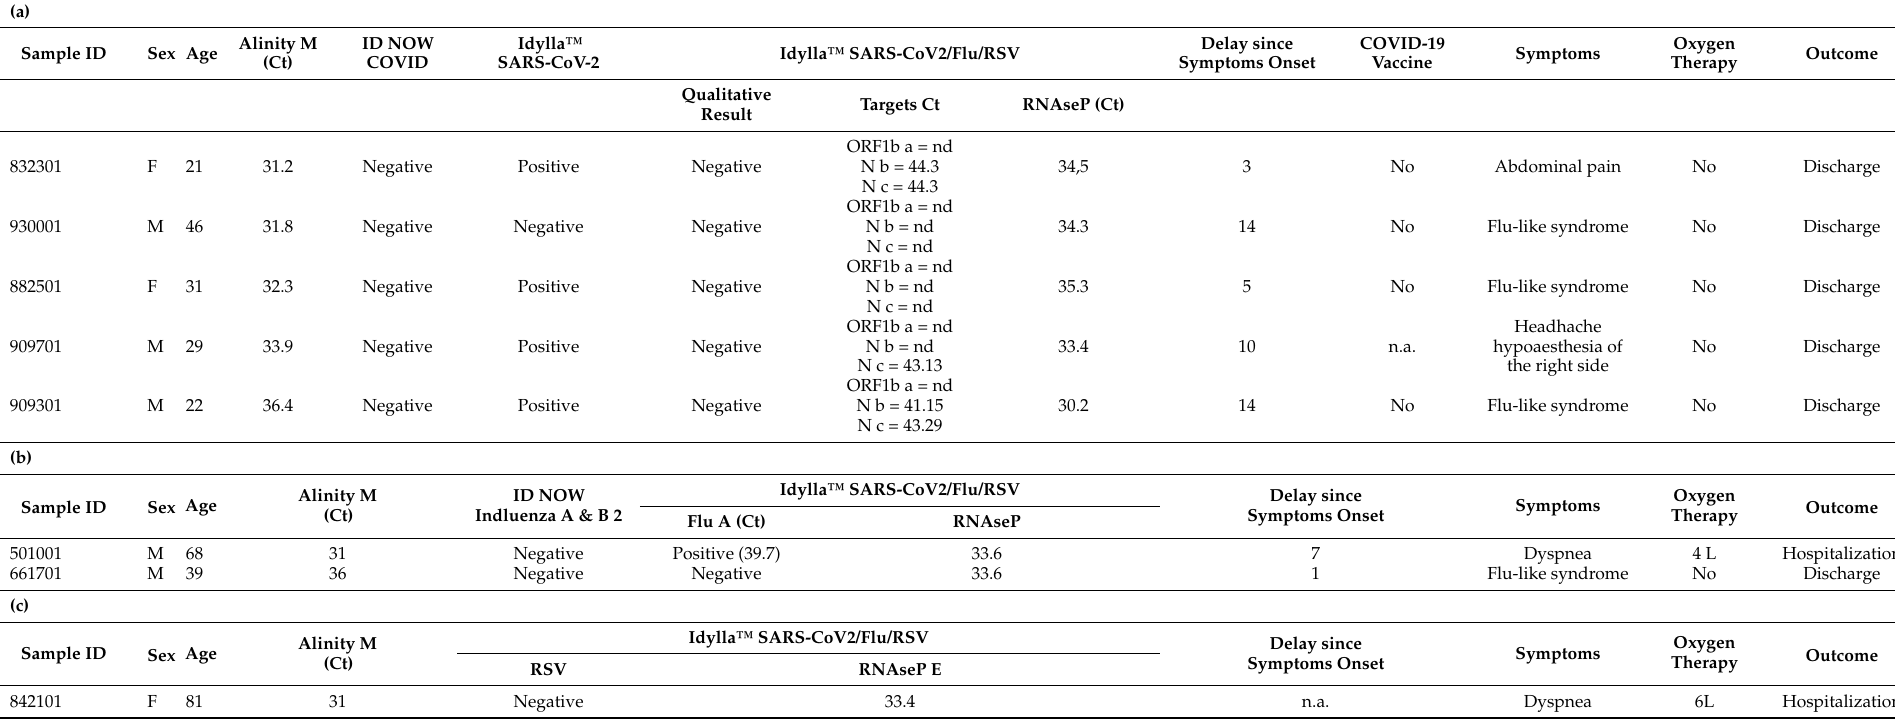
Table 5. Discrepancies between the Alinity M RESP-4-Plex and the evaluated assay for SARS-CoV-2 (a), influenza A (b), and RSV